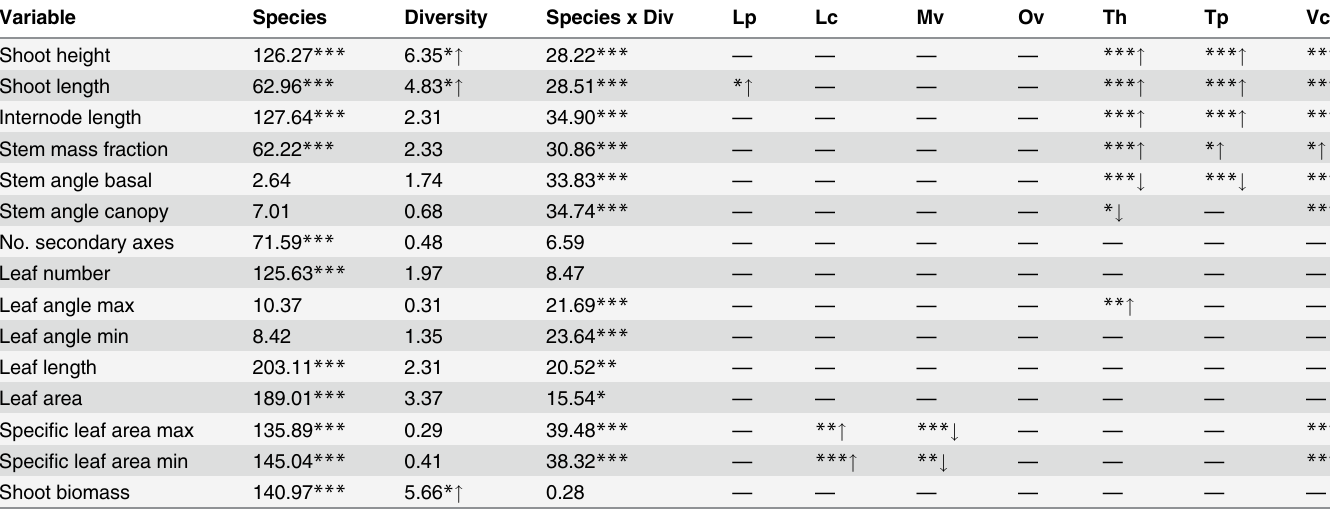
Table 2. Summary of mixed-effects models testing for effects of legume species identity and plant diversity on expression of traits related to light acquisition and performance in terms of shoot biomass.